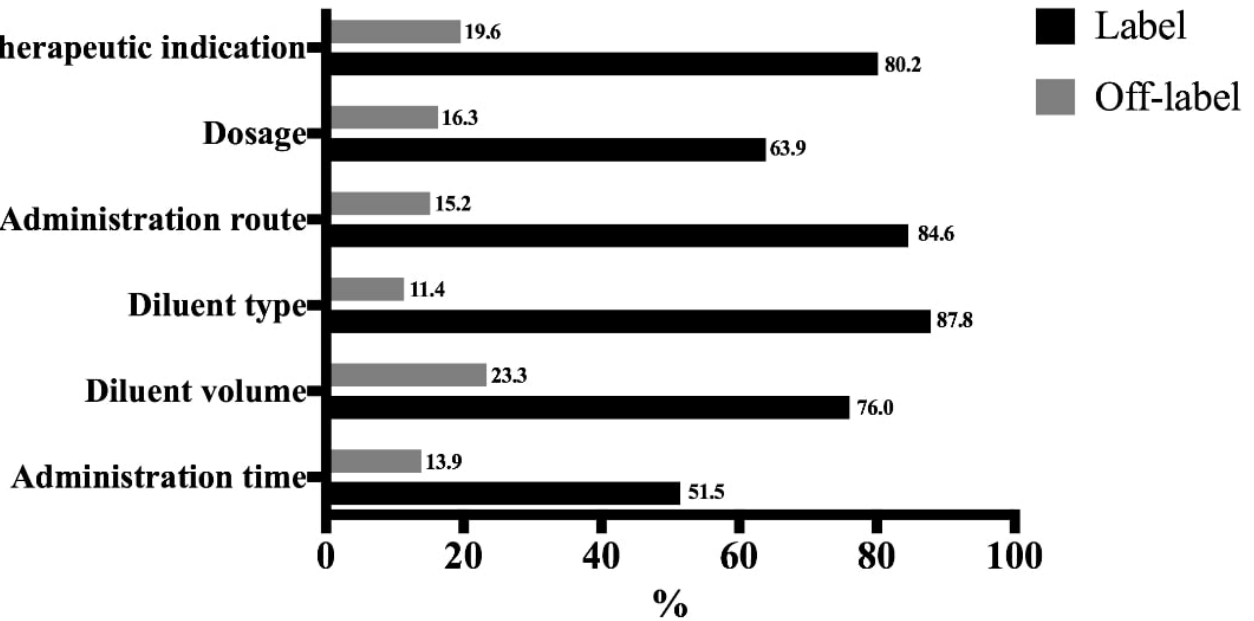
FIGURE 2 - Prevalence of off-label and label drug use for each of the categories assessed: therapeutic indication, dosage, route of administration, type and volume of diluent, and duration of